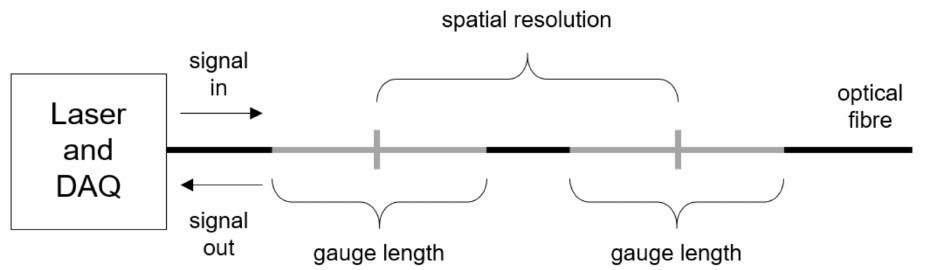
Figure 4. Diagram of spatial resolution and gauge length. DAQ stands for data acquisition